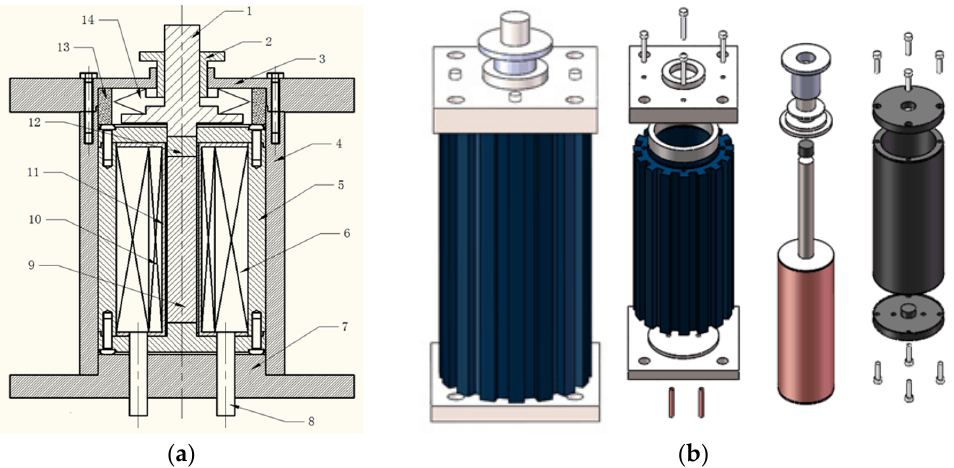
Figure 1. Schematic diagram of GMA structure: ( a ) Two-dimensional structure diagram: 1 output shaft, 2 preload nut, 3 head cover, 4 non-magnetic shell, 5 magnetic yoke, 6 drive coil, 7 base of GMA 8 cooling pipe, 9 Terfenol-D rod, 10 pickup coil, 11 coil frame, 12 magnetizer, 13 limit cylinder, 14 disk spring; ( b ) Solid diagram of GMA.